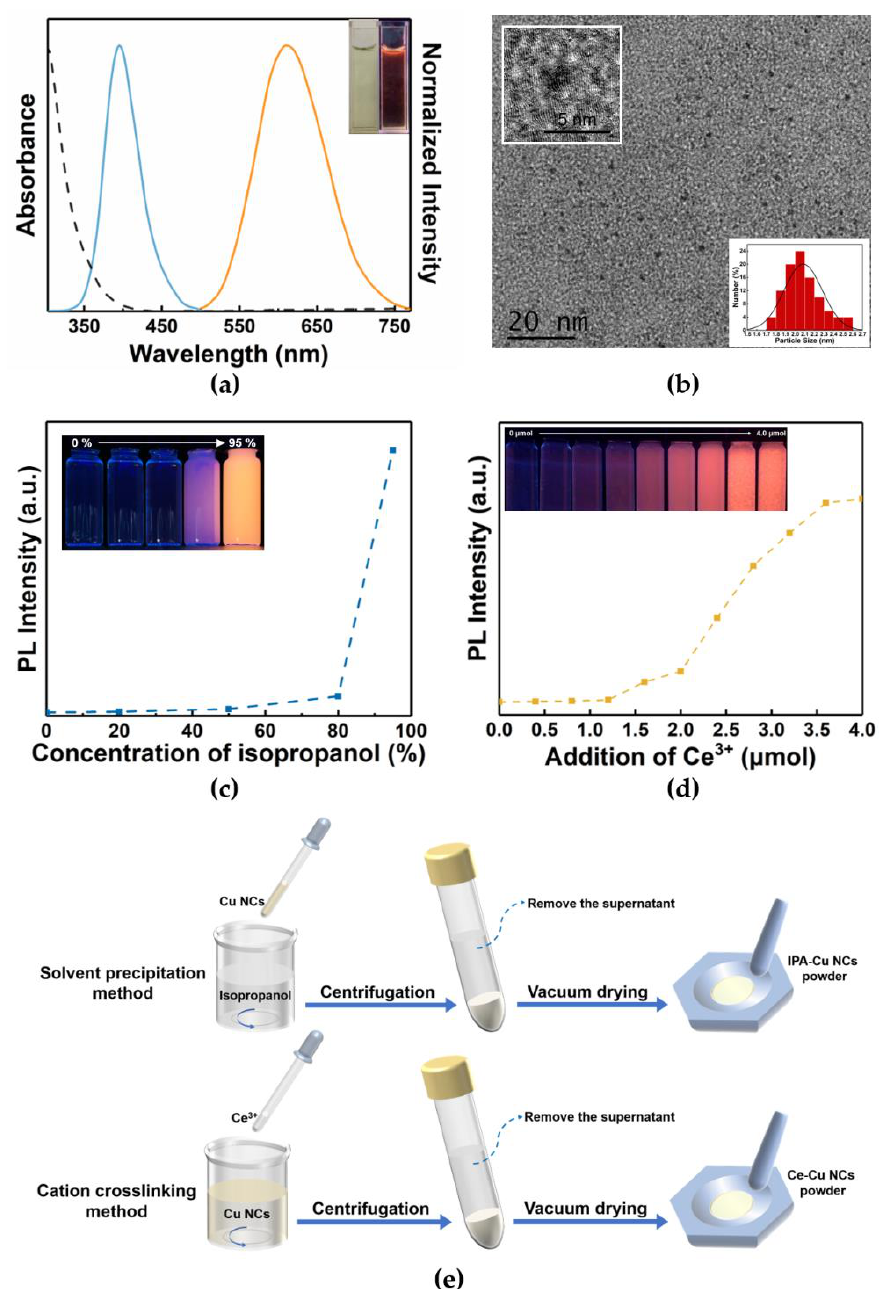
(Figure S10). The surface potential of the bare Cu NCs turned from negative to positive after adding Ce 3+ . This reversion was caused by the addition of Ce 3+ , which coordinated with the carboxyl groups of the surface molecules via electrostatic interaction.